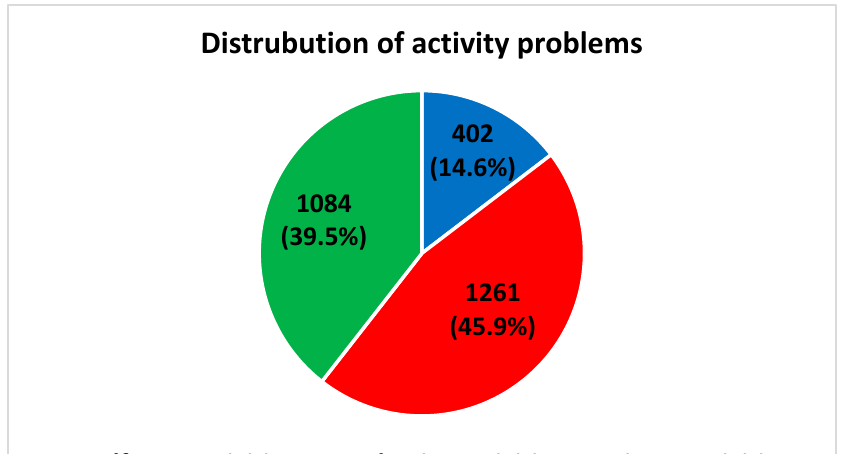
Figure 3. Patients with activity problems within the COPM subcategories: self-care (blue) comprising personal care, functional mobility and community management; productive activities (red) comprising paid/unpaid work, household management and play/school; leisure activities (green) comprising quiet recreation, active recreation and socialisation. Frequency ( n ) and relative frequency (%) of patients reported. COPM data based on 430 patients.